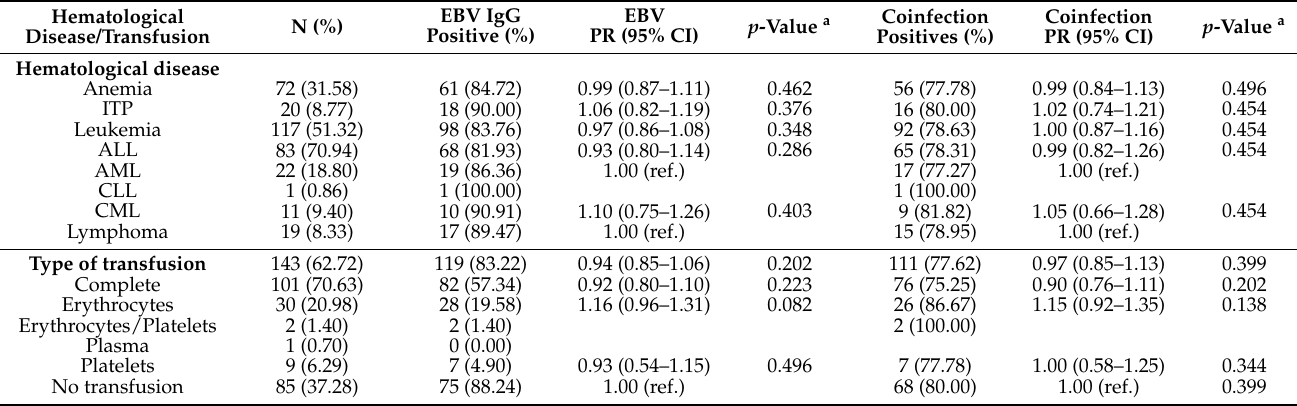
PR = Prevalence ratio; CI = Confidence interval; a Chi-square with Yates’ correction; Prevalence Risk CI calculated by the method Koopman asymptotic score; ALL = Acute Lymphocytic Leukemia; AML = Acute Myeloid leukemia; CLL = Chronic Lymphocytic Leukemia; CML = Chronic Myeloid Leukemia.